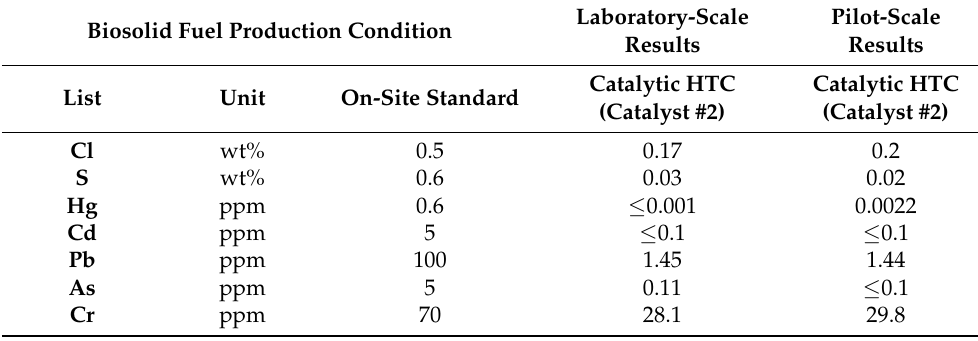
Table 8. Laboratory- and pilot-scale hydrothermal carbonization solid fuel comparison according to heavy metal and hazardous substance standards of biosolid